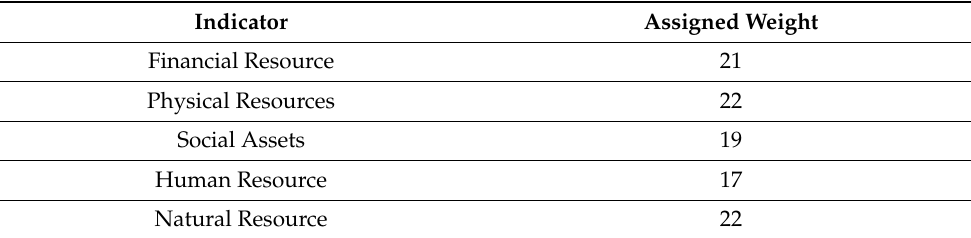
Table 3. Community-Based Asset Weighting